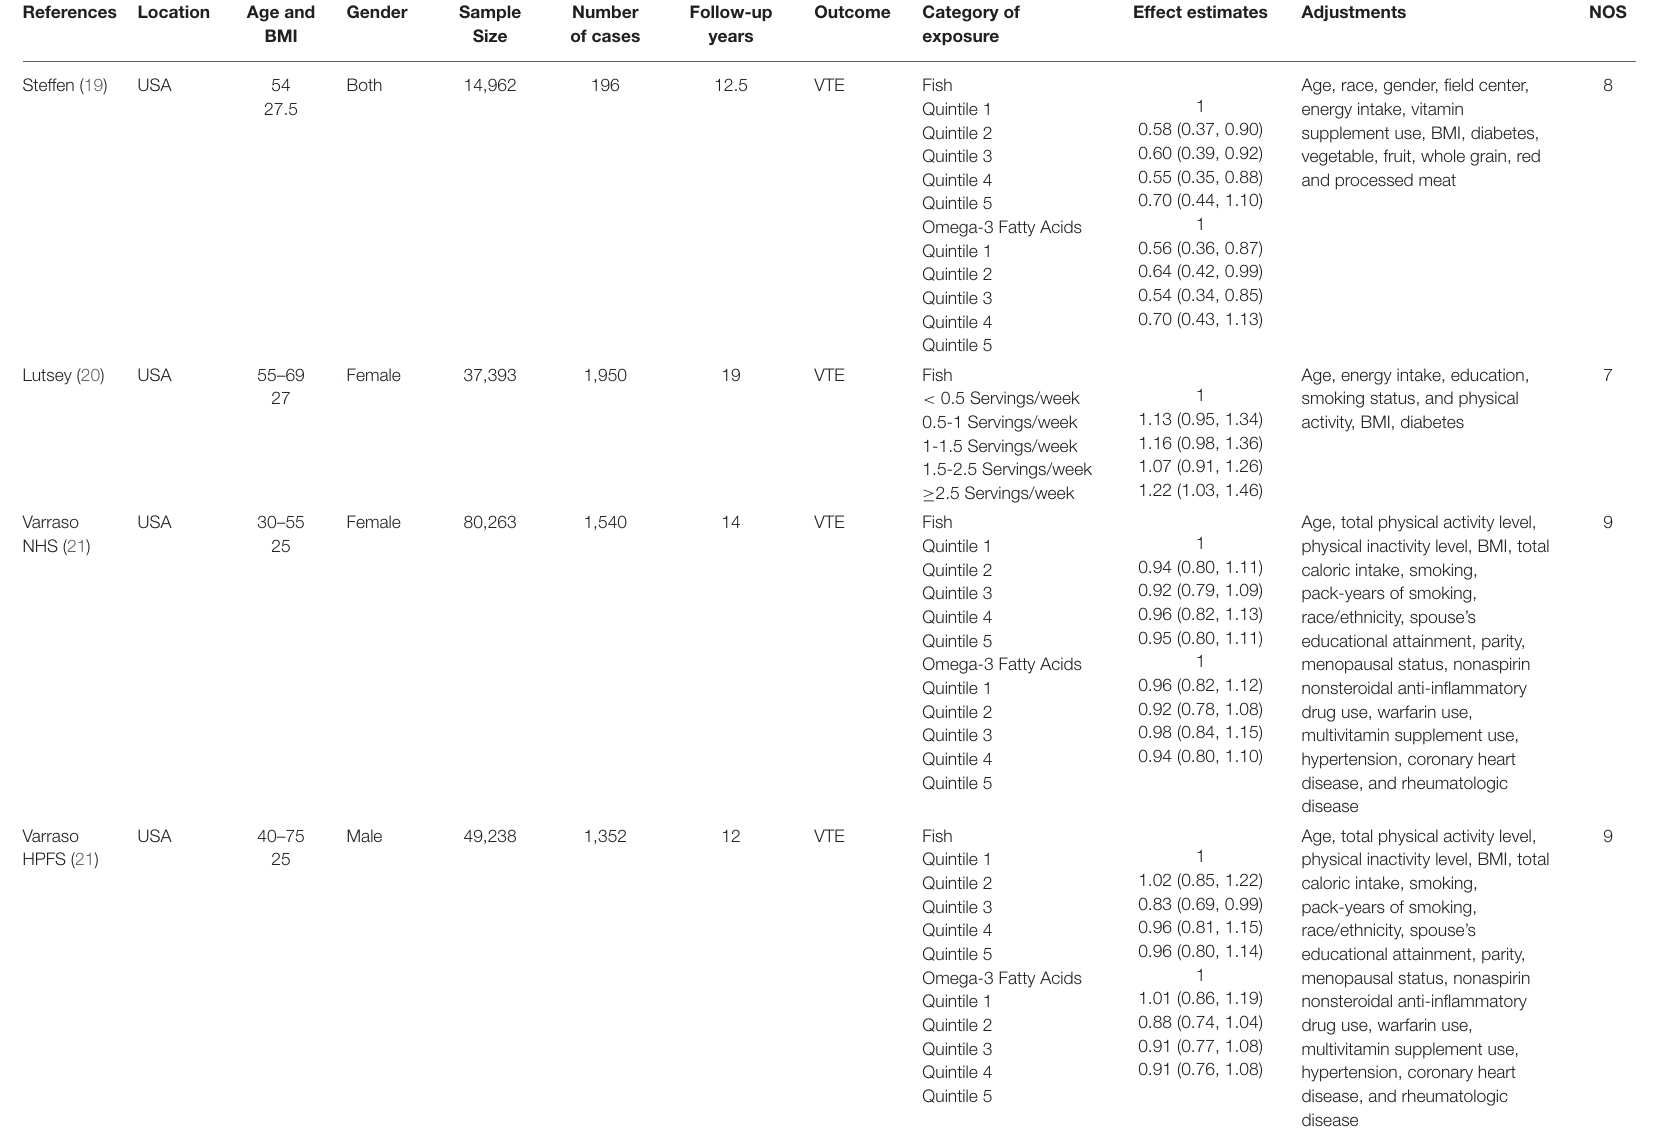
TABLE 1 | Characteristics of the individual studies included in this